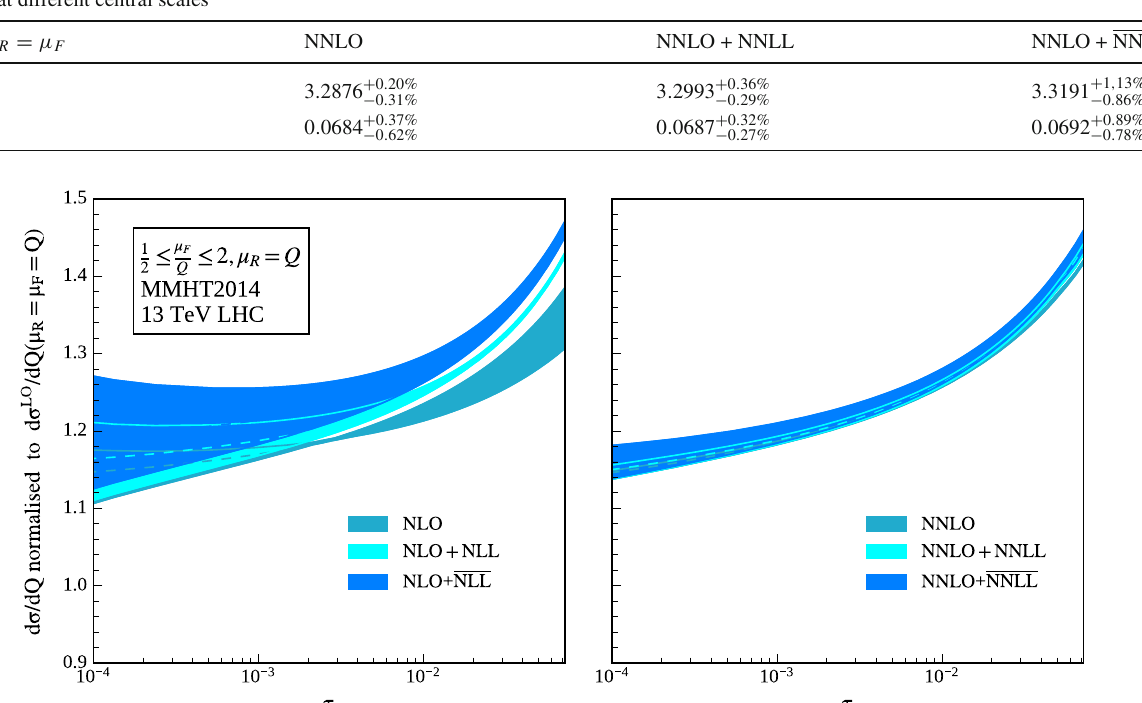
Fig. 11 μ F variation between SV and SV + NSV resummed results matched to NLO (left panel) and NNLO (right panel) with the scale μ R held fixed at